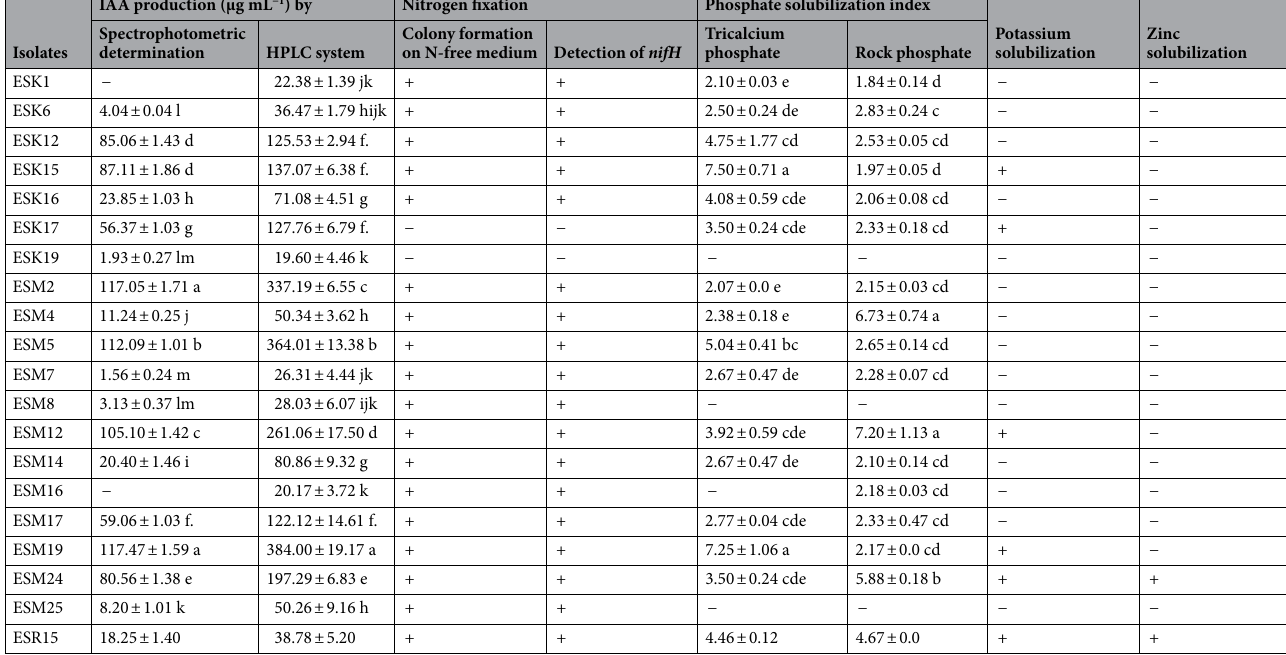
Table 2. Indole-3-acetic acid (IAA) production and nutrient acquisition by different halotolerant biofilm- producing rhizobacterial isolates. The values are mean of three independent experiments. ± indicates standard deviation. Values having different letters are significantly different from each other according to Fisher’s least significant difference (LSD) test ( p ≤ 0.001). Pseudomonas chlororaphis ESR15 was used as positive